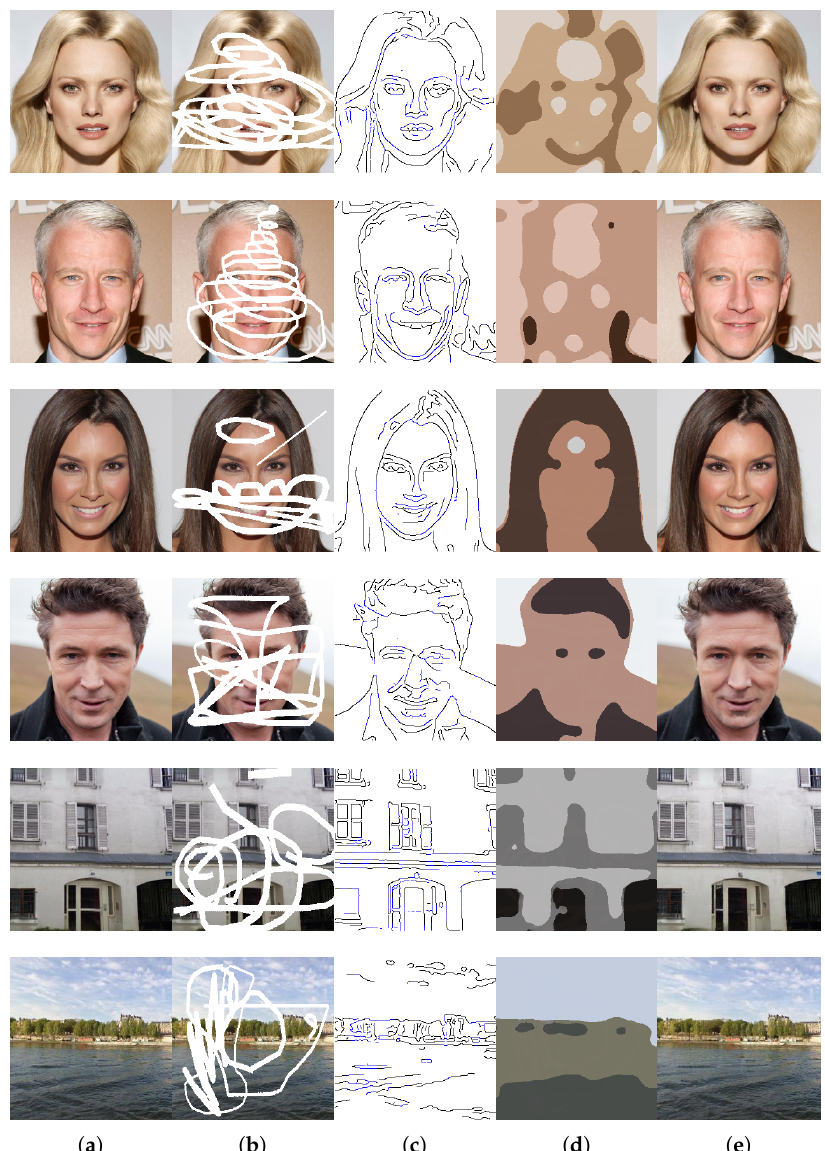
Figure 4. The images produced by PIC-EC. ( a ) ground truth images; ( b ) masked images; ( c ) generated edge maps by G 1 ; ( d ) generated color maps by G 2 ; ( e ) completion results without any post-processing, best viewed with